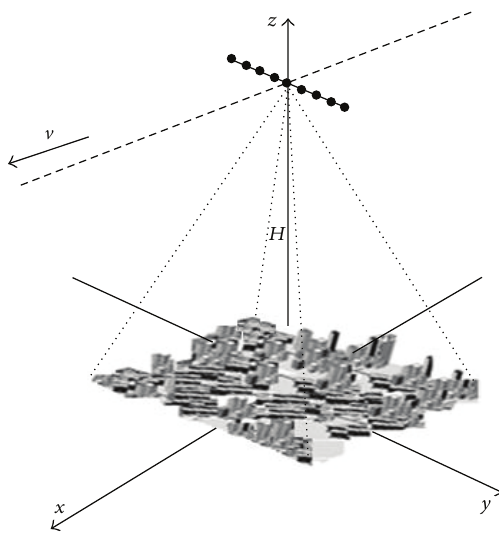
Figure 1: Geometry of down-looking sparse array SAR.